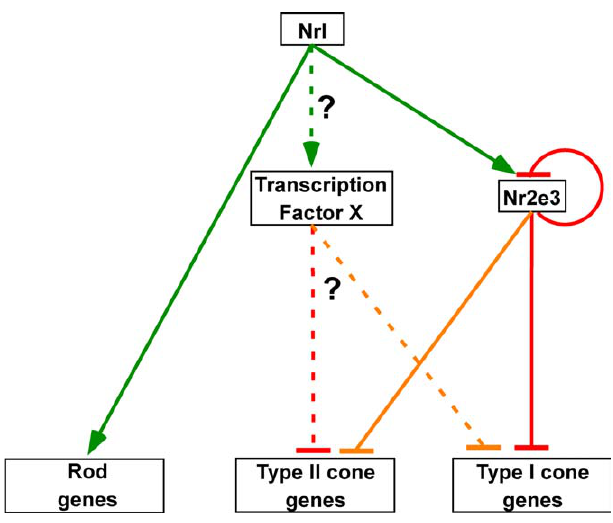
Figure 8. A Partial View of the Rod Photoreceptor Transcriptional Regulatory Network Note that green lines indicate activation, and yellow and red lines indicate weak and strong repression, respectively. The dotted lines associated with a question mark indicate that it is not known whether Nrl directly represses the target genes in question or whether its repression is mediated by a downstream transcription factor ( ‘‘ X ’’ ). Note that Nr2e3 appears to negatively regulate its own transcription. The regulatory linkages depicted in this diagram are not necessarily direct. The weak activation of some rod-specific genes by Nr2e3 is omitted from this diagram for clarity. Also not shown is the role of other photoreceptor transcription factors, such as Crx . DOI: